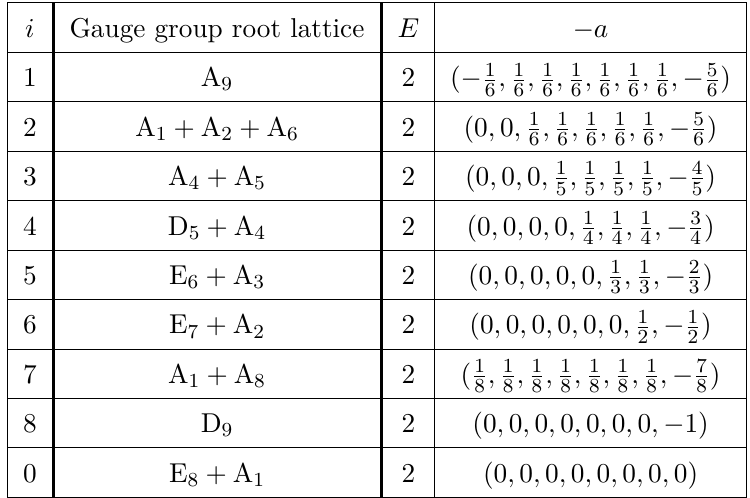
Table 3 . Maximal enhancements in the nine-dimensional theory, obtained by deleting the i th node in the GDD shown in figure 1. All groups arise at level 2. The Wilson line is always of the form a = w i /κ i (cf. table